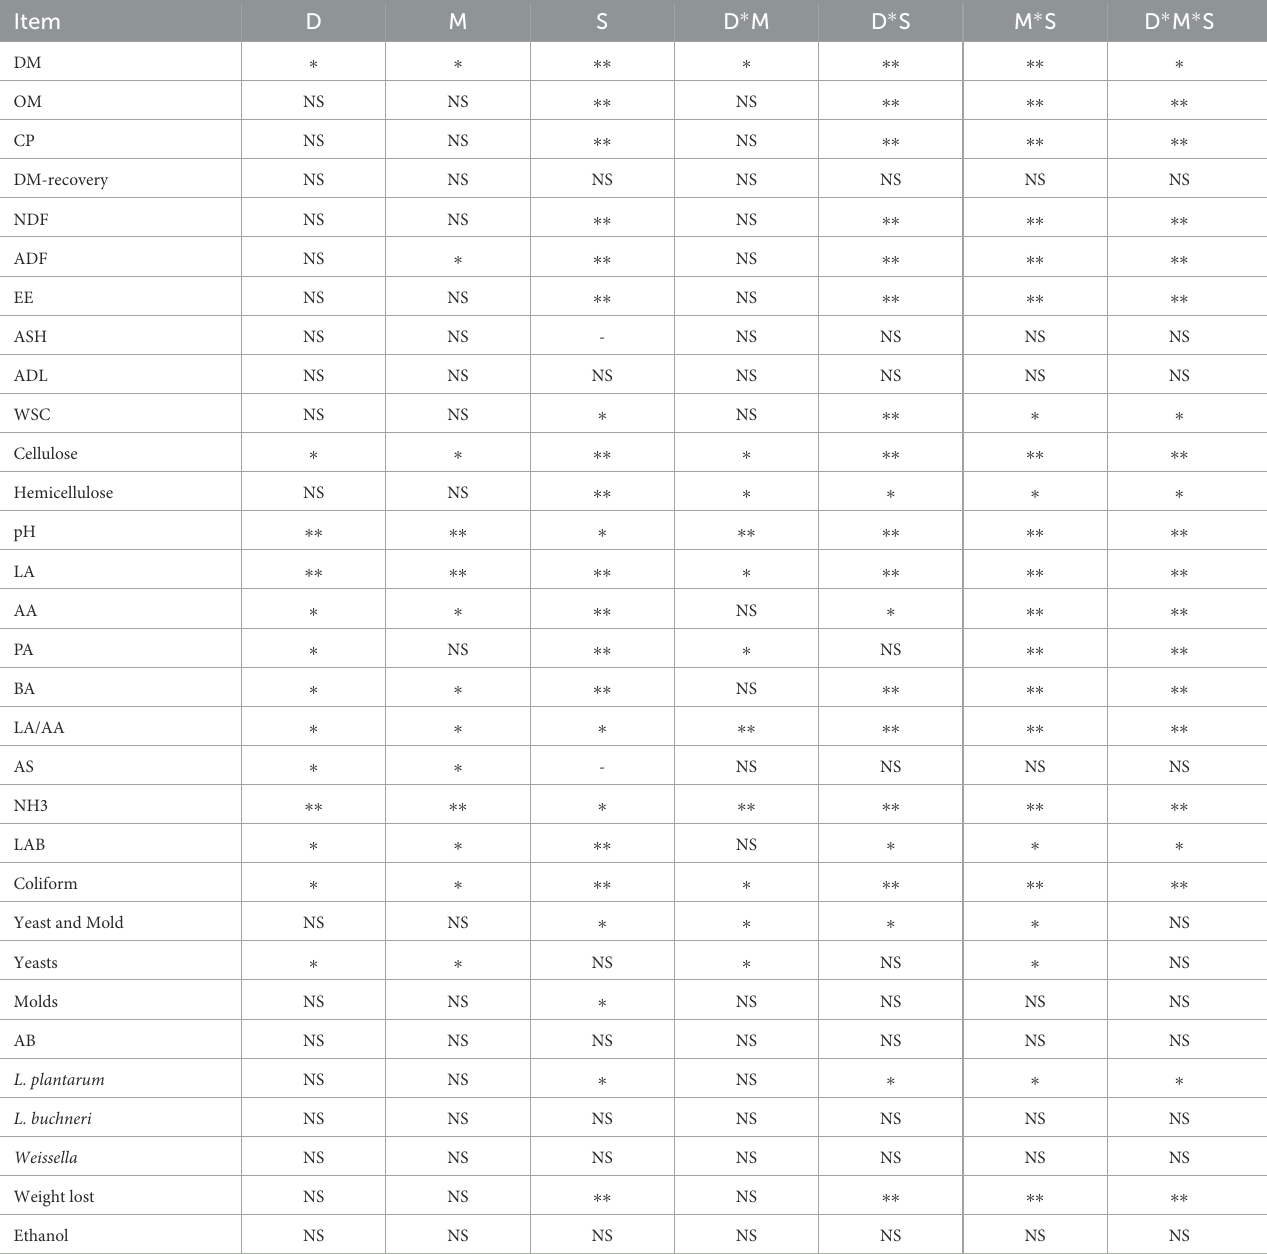
TABLE 2 Interaction effects of lactic acid bacteria dose, types, and silage substrates on chemical composition and silage quality.